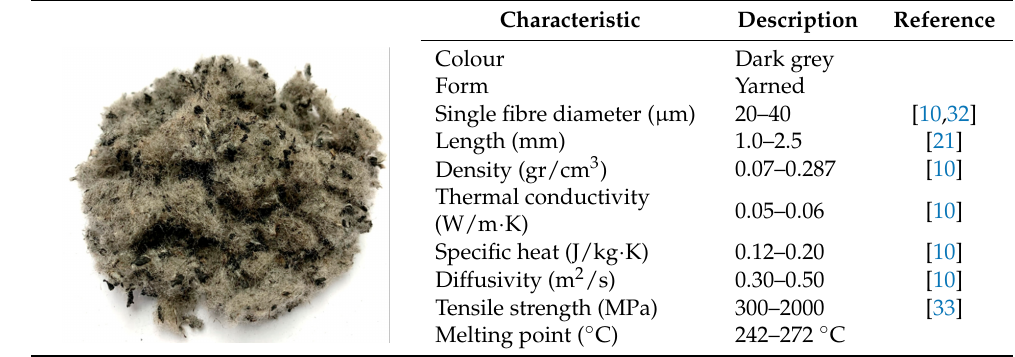
Table 1. Properties of the textile fibre originating from end-of-life tyres.